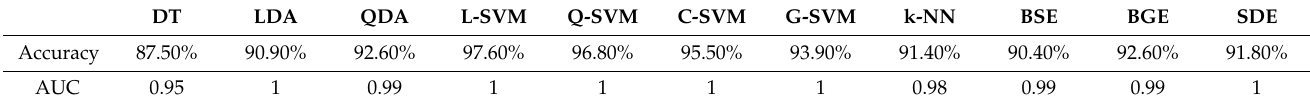
Table 3. Results show the classification accuracy and area under curve (AUC) for each of the classifiers. the classifiers. Figure 4 depicts the confusion matrix for each of the algorithms used. Here, DT = Decision Tree, LDA = Linear Discriminant Analysis, QDA = Quadratic Discriminant Analysis, L- the order of appearance of sub-figures (from left to right) is a = Decision Tree (Model 6.1), SVM = Linear Support Vector Machine, Q-SVM = Quadratic Support Vector Machine, C-SVM = Cubic b = Linear Discriminant Analysis (Model 6.4), c = Quadratic Discriminant Analysis (Model Support Vector Machine, G-SVM = Gaussian Support Vector Machine, k-NN = K-Nearest Neighbor, 6.5), d = Linear Support Vector Machine (Model 6.6), e = Quadratic Support Vector Ma- BSE = Boosted Tree Ensemble, BGE = Bagged Tree Ensemble, and SDE = Subspace Discriminant Ensemble Learner.